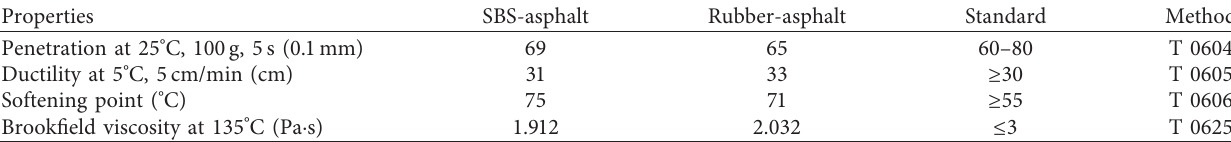
Table 1: Basic properties of SBS-modified asphalt and rubber-modified asphalt.